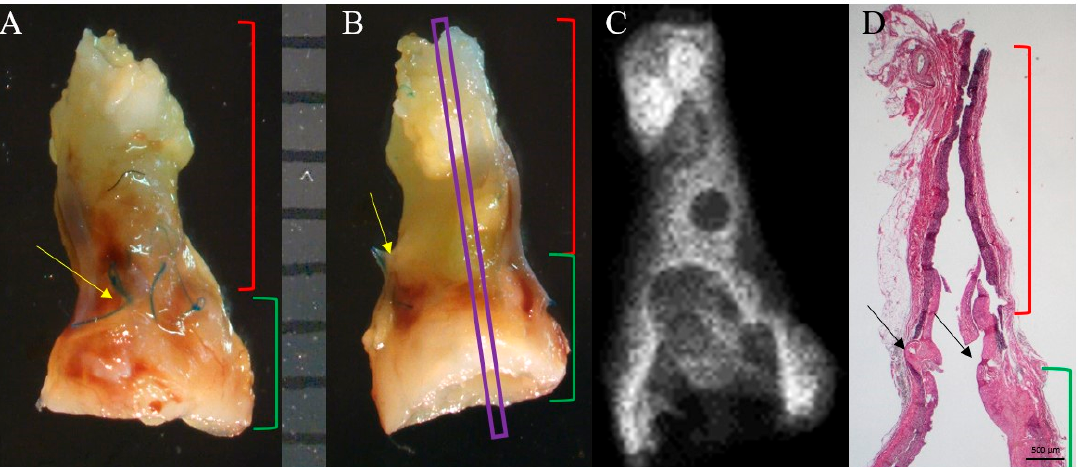
Figure 5. ( A , B ) Macroscopic images of the PAG and the near aorta 69 days after surgery. The PAG (green stapes) appeared more dilated than the infrarenal abdominal aorta (red stapes). Yellow and black arrows indicate the sutures. ( C ) Radiography of the explant: no calcifications were visible. ( D ) Histological image of the entire explant in correspondence to the purple section in ( B ); the same portions indicated in ( A , B ) are highlighted. Weigert-Van Gieson, original magnification 12.5×.